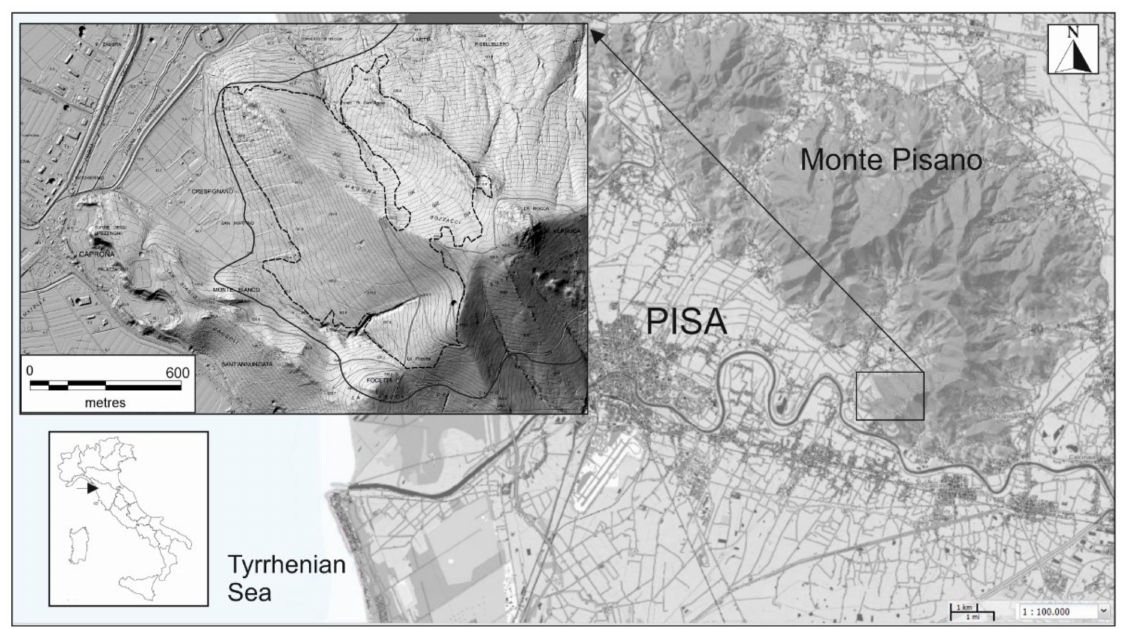
Figure 1. Geographic location of the study site and fire limits (2009 limits–2018 limits). (Map data: Geoscopio Regione Toscana, https://www.regione.toscana.it/-/geoscopio, accessed